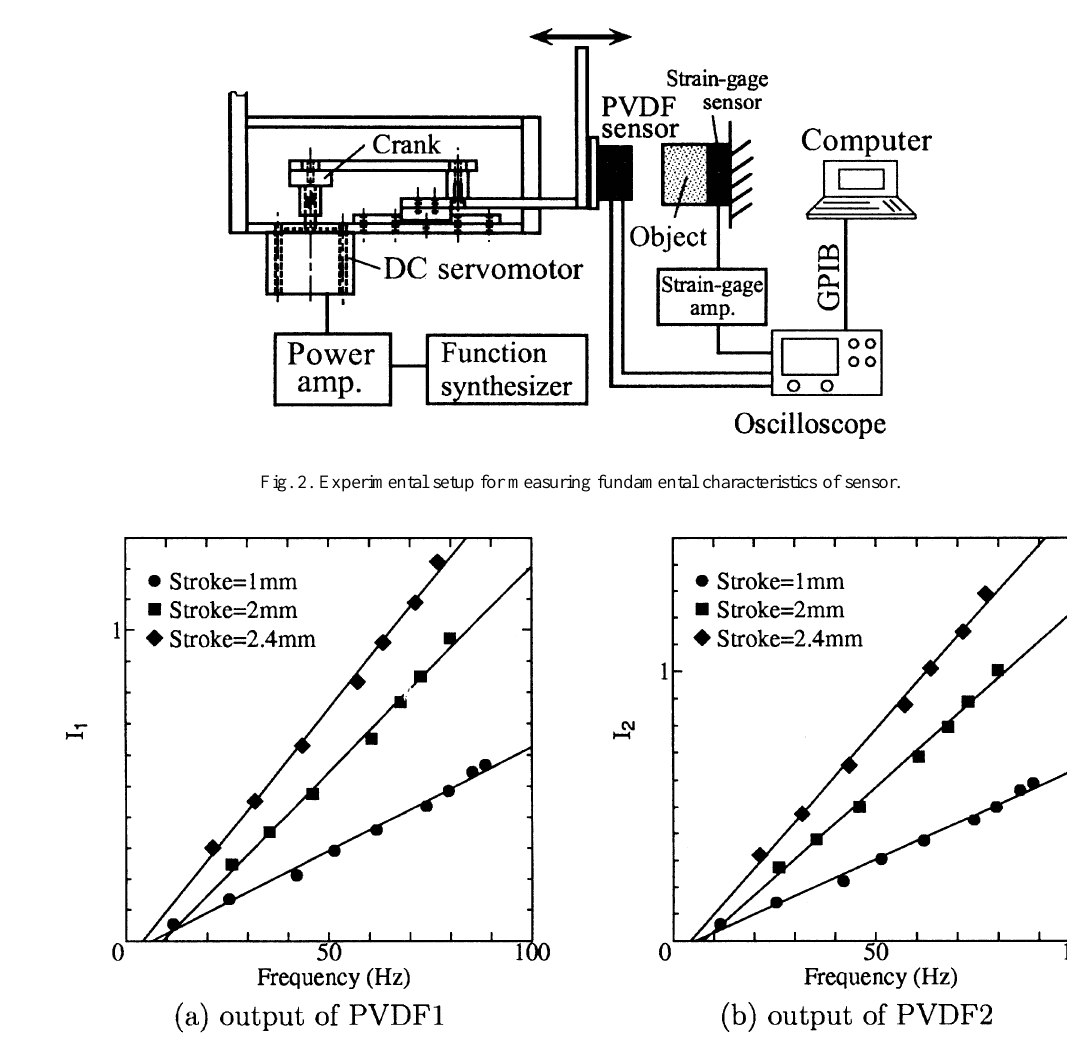
Fig. 1. Rectangular sensor with plane surface and objects.